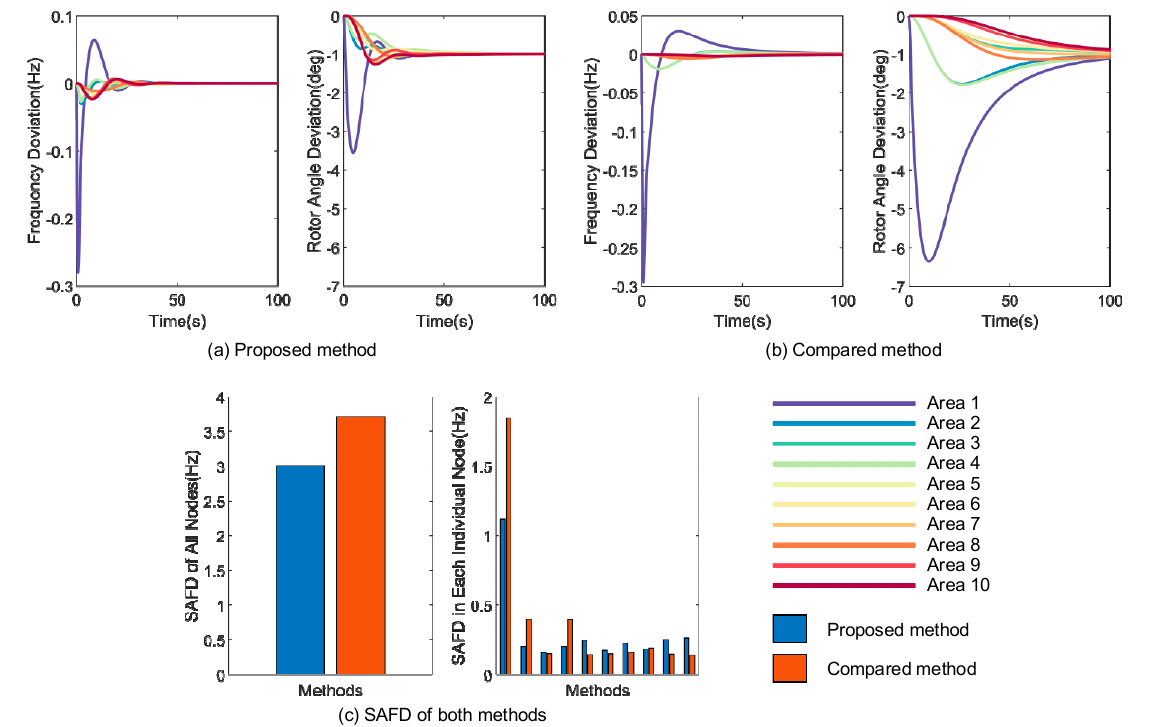
Figure 7. Frequency deviation, rotor angle deviation and sum of absolute frequency deviation (SAFD) of both methods in the frequency event A.